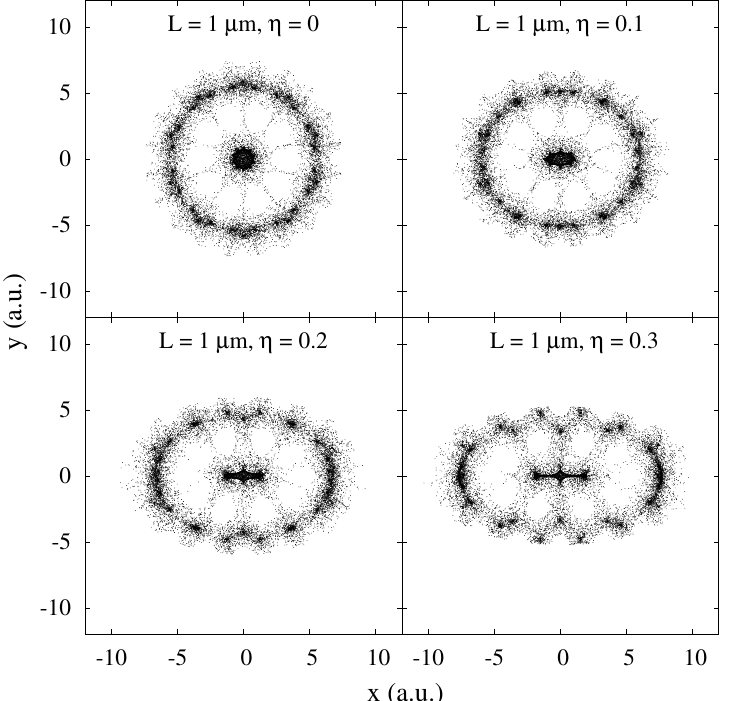
Figure 3. The spatial distributions of protons channeled in the radially deformed DWNTs(10, 0)@(5, 0) under different radial strains: (left top) η = 0; (right top) η = 0.1; (left down) η = 0.2; (right down) η = 0.3, respectively. The proton energy is E = 1 GeV and nanotube length is L = 1 µ